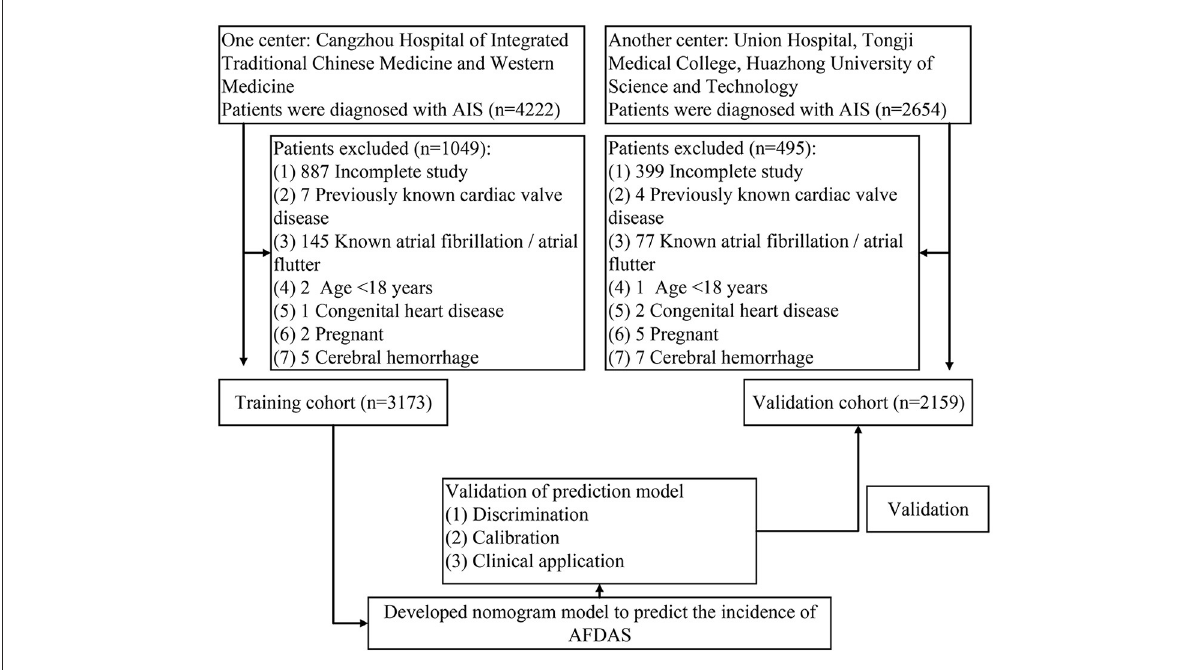
FIGURE1 The flow chart of developing and validating the